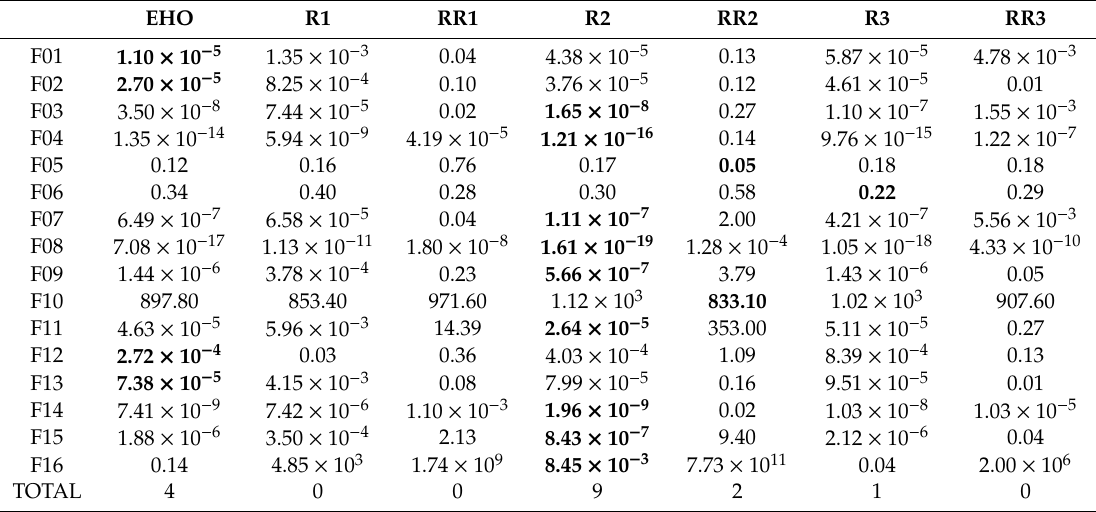
Table 7. Standard values obtained by EHO and six improved methods with D =